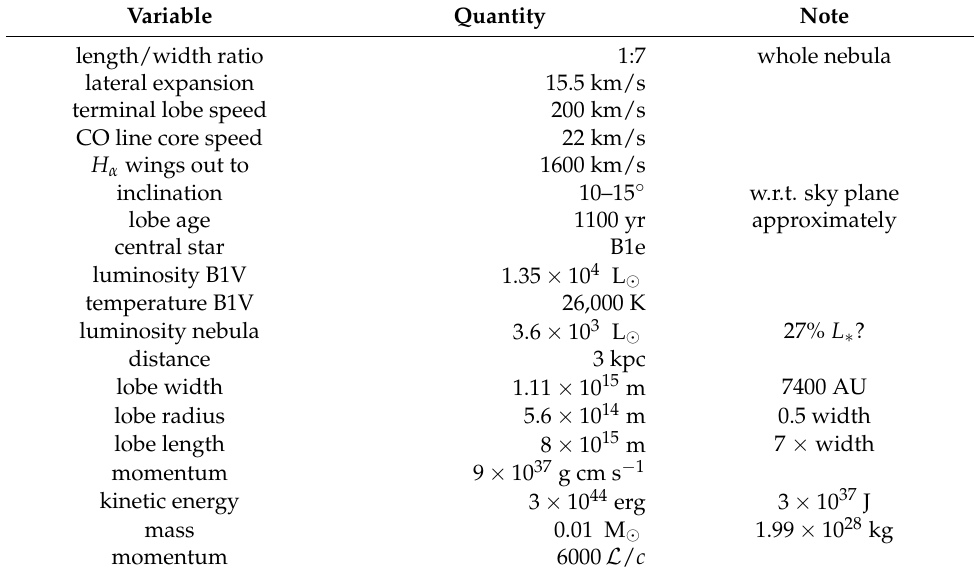
Table 1. Summary of observed data of Hen